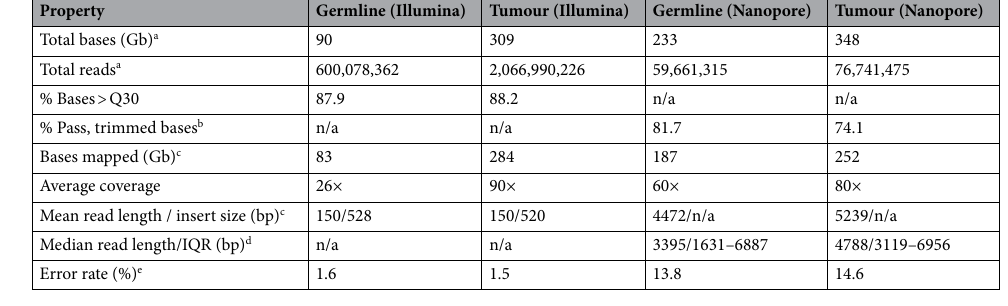
Table 1. Summary of sequencing data. a For Illumina, numbers given are for total number of pass-filter reads/ bases. b For Nanopore, ‘pass’ reads are those given qscore > 7 by the basecaller. Trimming refers to adapter trimming by porechop. c For Illumina, these numbers are taken from the deduplicated bam files. d Unmapped reads were removed before calculating median raw read length for the Nanopore data. e Mismatches/bases